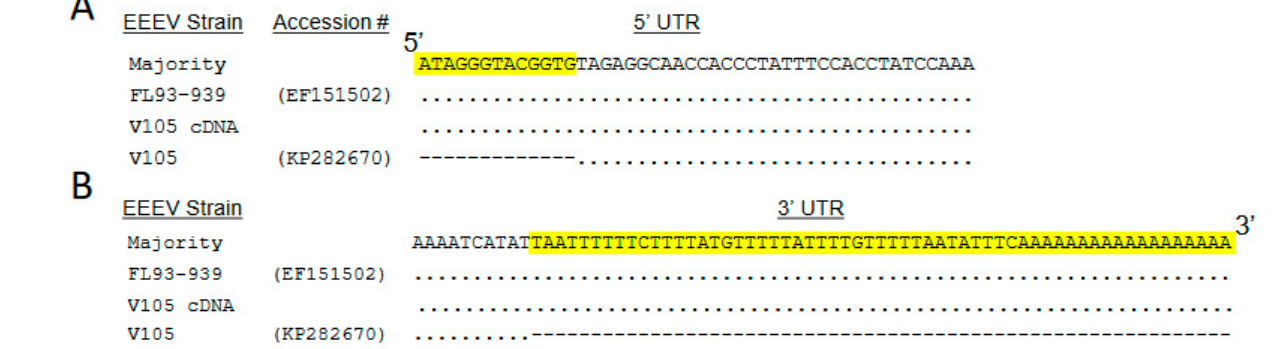
Figure 2. Alignment of selected regions of the 5‘ UTR ( A ) and 3 ′ UTR ( B ) showing nucleotide sequence information missing from the GenBank V105 sequence (yellow highlight) and sequence from FL93-939 used for the V105 cDNA clone. ( A ) Only 2 of 88 North American EEEV 5 ′ UTR sequences in GenBank had any differences with FL93-939 in the added region. ( B ) The added sequence is identical for 17 sequenced NA isolates including FL93-939.